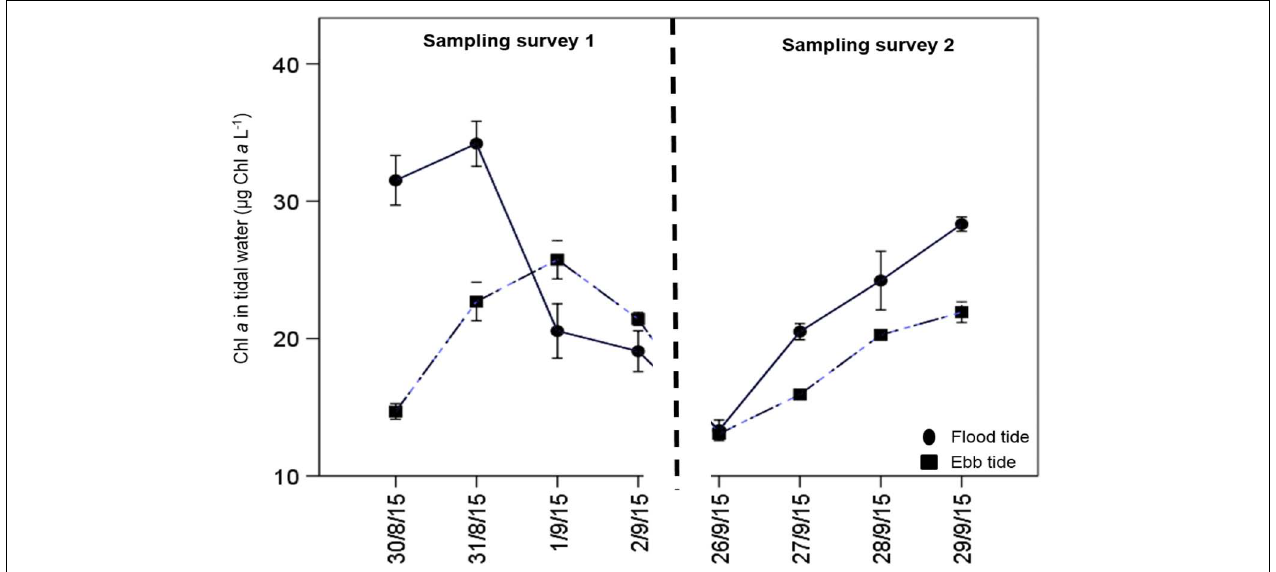
FIGURE 4 | Daily variability in water column Chl. a in flood and ebb tidal water on the same tide over the salt marsh in both surveys 1 and 2 at Fingringhoe Wick, Colne Estuary, Essex, United Kingdom, in August and September 2015. Values are mean ± SE, n of tidal water = 3. The difference between the flood and ebb lines material retained on the marsh over the tidal